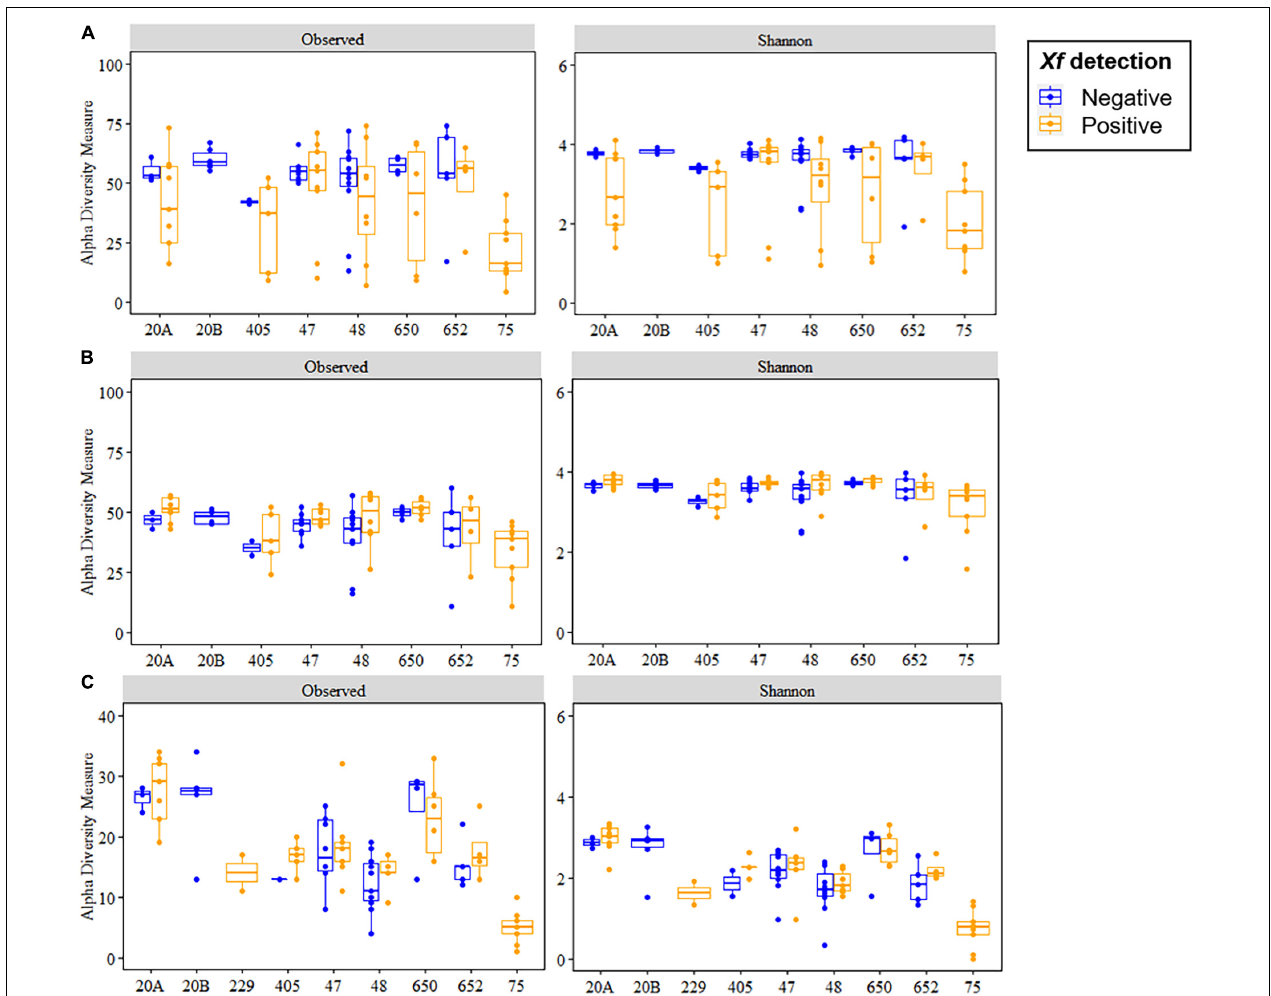
FIGURE 2 | Boxplots of Richness (observed) and Shannon diversity indices for bacterial (A,B) and fungal communities (C) at the amplicon sequence variant (ASV) taxonomic level in the xylem of Xylella fastidiosa -qPCR negative and positive almond trees sampled in different orchards in Alicante province. X. fastidiosa ASVs were maintained (A) or removed (B) from the data set before analysis. The boxes represent the interquartile range, while the horizontal line within the box defines the median and whiskers represent the lowest and highest values of four values for each treatment